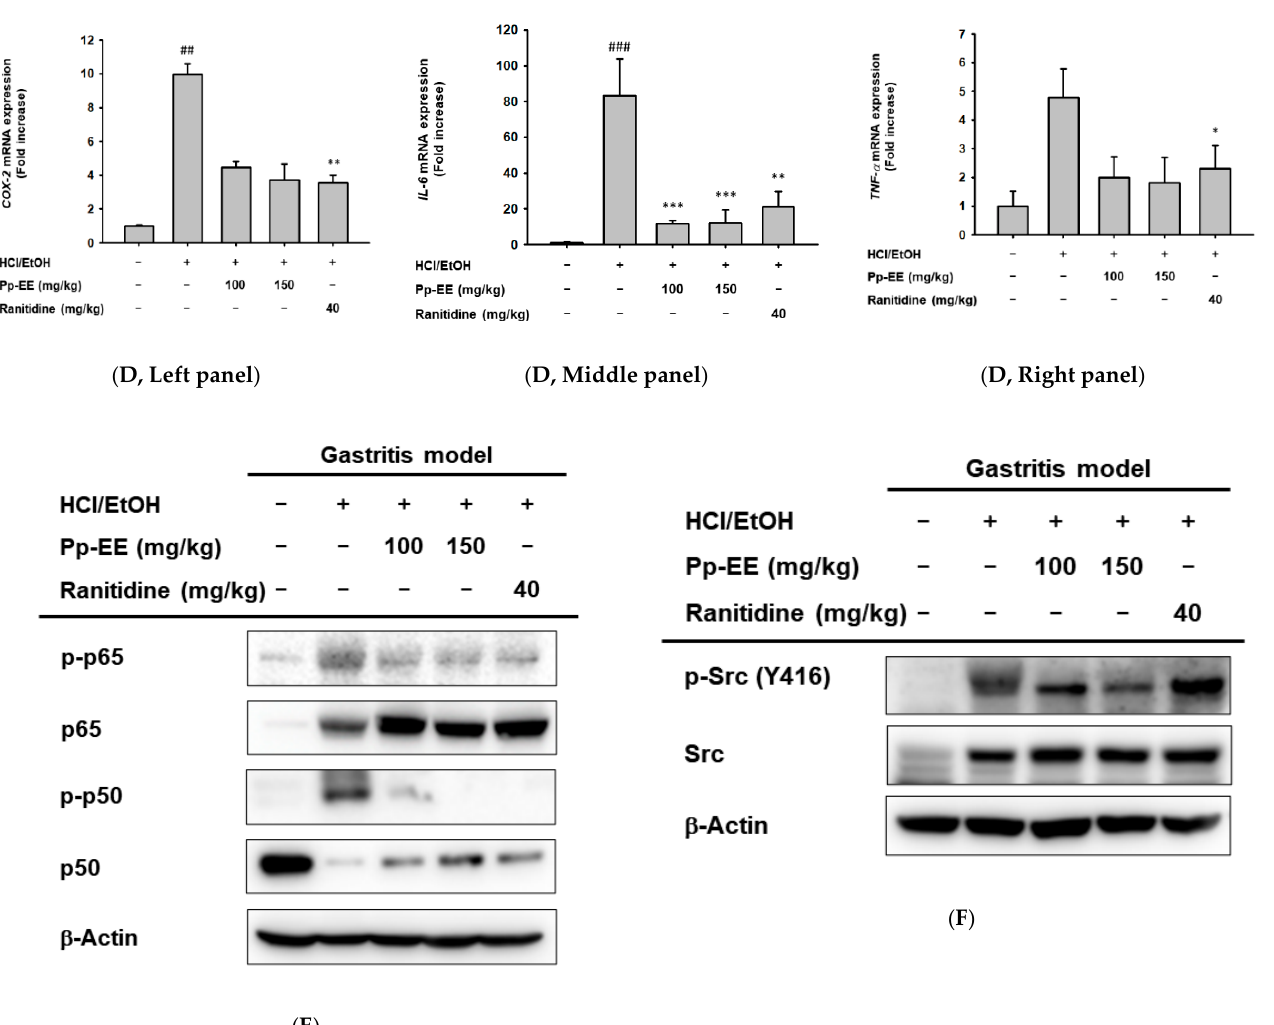
Figure 4. Anti-inflammatory effects on HCl/EtOH-induced gastritis model. ( A ) Schematic diagram of an experiment using the acute gastritis model. ICR mice were separated into a total of five groups and were orally administered three times 100 μ L of the drug corresponding to each group: a normal group and a negative control group (0.5% carboxymethylcellulose (CMC)), treatment groups (100 mg/kg Pp-EE or 150 mg/kg Pp-EE), or positive control group (40 mg/kg ranitidine). Five hours after the last dose, mice were orally administrated 200 mM HCl/60% EtOH (300 μ L/mouse) to induce acute gastritis and sacrificed after 1 h. ( B ) and ( C ) Dissected stomachs were photographed, and the incidence of lesions was quantified using ImageJ. ( D ) Comparison of mRNA expression of inflammatory genes ( COX-2 (Left panel), IL-6 (Middle panel), and TNF- α (Right panel)) in the stomach was conducted using real-time PCR ( E , F ) The protein levels in the stomach were detected by an immunoblotting assay. ###: p < 0.001 and ##: p < 0.01 compared to the normal group, *: p < 0.05, **: p < 0.01, and ***: p < 0.001 compared to the control group. − : no treatment and +: treatment.